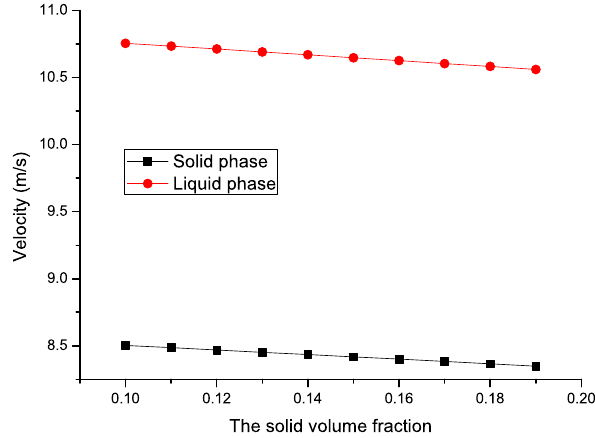
Figure 2. Solid- and liquid-phase velocity variations of a de- bris flow from the channel position x = 0m to the channel posi- tion x = 300m: ρ s = 2400kgm − 3 , ρ f = 1500kgm − 3 , d e = 0.10m, ϕ s = 0.10, θ = 30 ◦ , ( τ B + µb)d 0 = 100, k = 3.72, g = 9.8. 2 = v 2 (M 1 + M 2 − ϕ f G 1 − ϕ f G 2 ), s ρ s